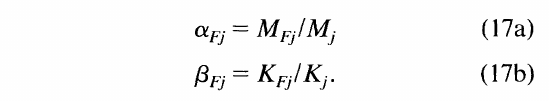
FIGURE 4 Plan of example tall buildings (dimensions in meters).